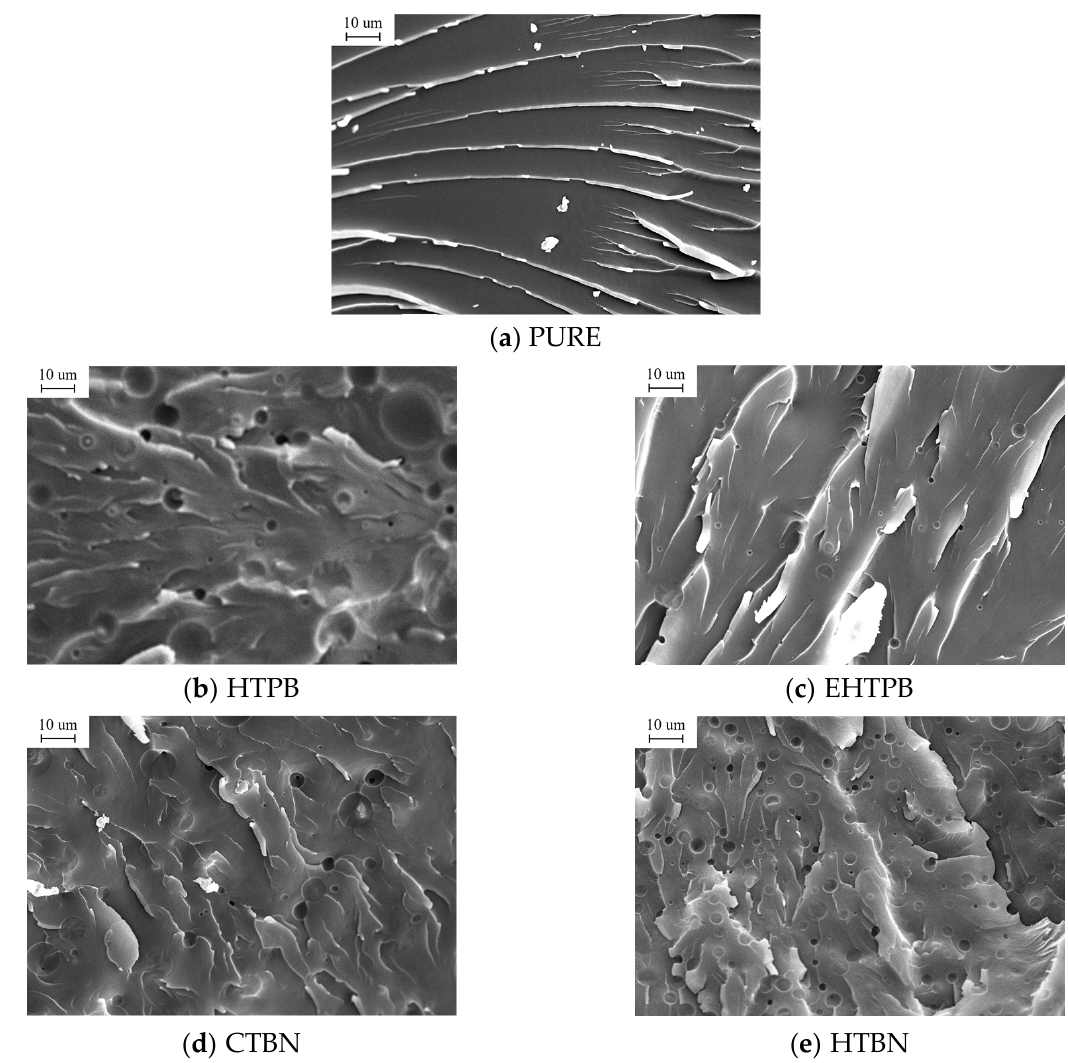
Figure 3. SEM photographs of epoxy resins toughened by different liquid rubbers. ( a ) PURE; ( b ) HTPB; ( c ) EHTPB; ( d ) CTBN; ( e ) HTBN. Liquid rubber exists in the cured epoxy resin as discontinuous